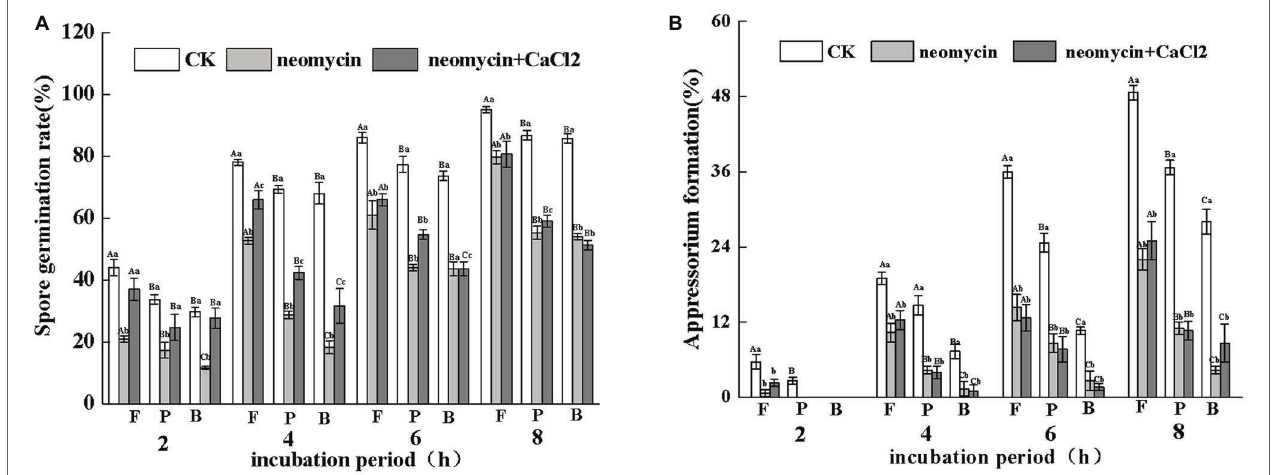
FIGURE 6 | Effects of PLC on spore germination rates (A) and appressorium formation rates (B) induced by fruit wax (F), paraffin (P), and beeswax (B). Conidial suspensions treated with neomycin (10 μ M) and exogenous Ca 2+ (1 mM) were incubated on inductive hydrophobic membranes coated with different waxes. Vertical lines indicate the standard error (± SE ) of the mean. Uppercase letters indicate inter-group differences. Lowercase letters indicate intra-group differences. Different letters indicate significant differences between the treatments ( p <